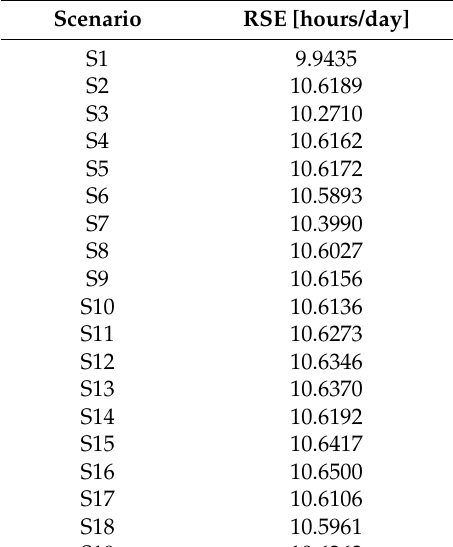
Table 2. RSE values for VGR mix scenarios.